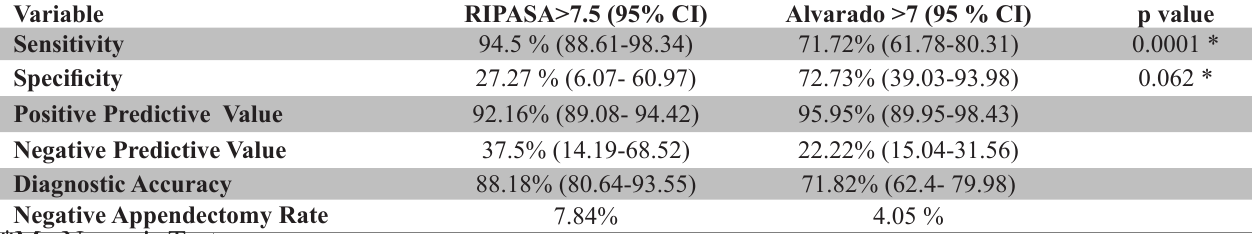
Table 4. Comparison between RIPASA and Alvarado scoring